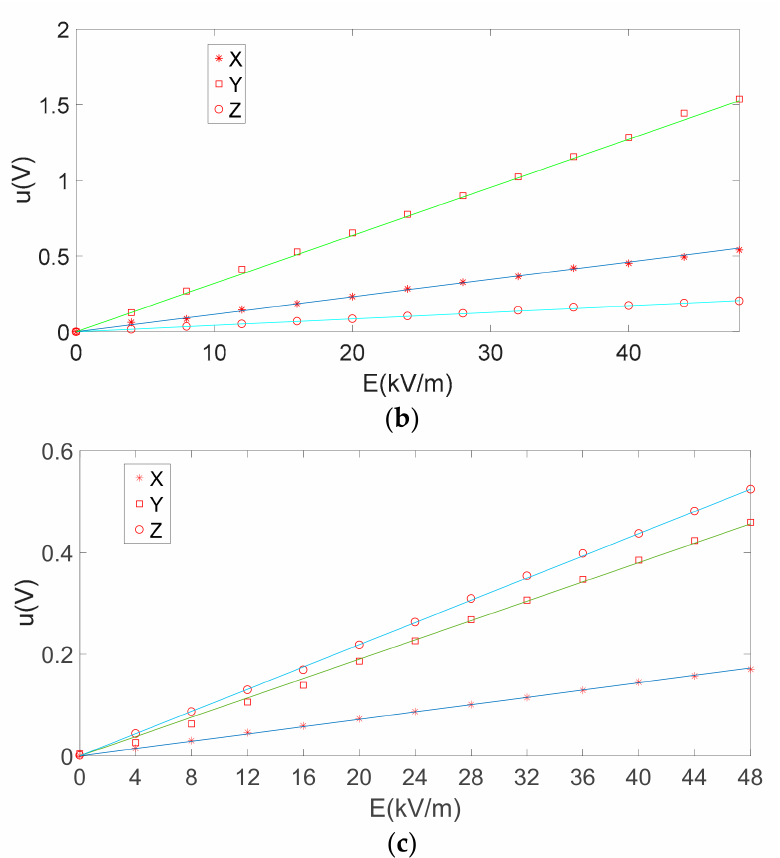
Figure 6. The amplitude of the induction electrodes output voltage; ( a ) X axis direction; ( b ) Y axis direction; ( c ) Z axis